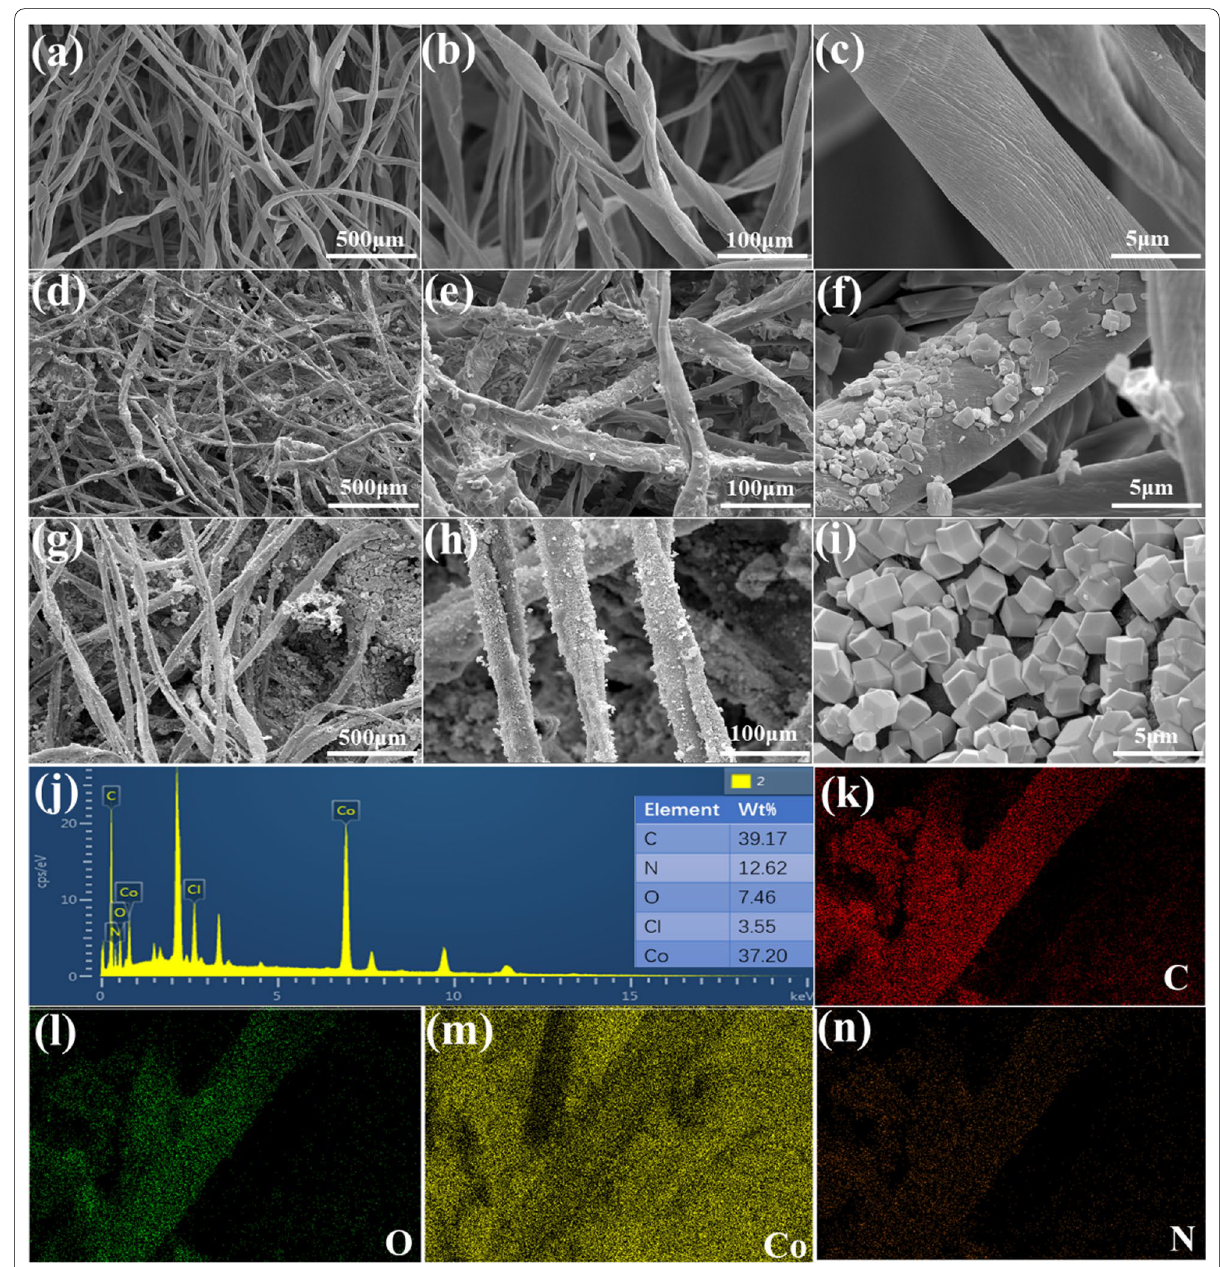
Fig. 3 SEM images of the pristine cotton fibers ( a – c ), CHC-deposited cotton fibers (d-f) and ZIF-67/cotton fibers ( g – i ); EDS spectrum of the ZIF-67/ cotton fibers ( j ) and corresponding mapping images: C ( k ), O ( l ), Co ( m ), N ( n